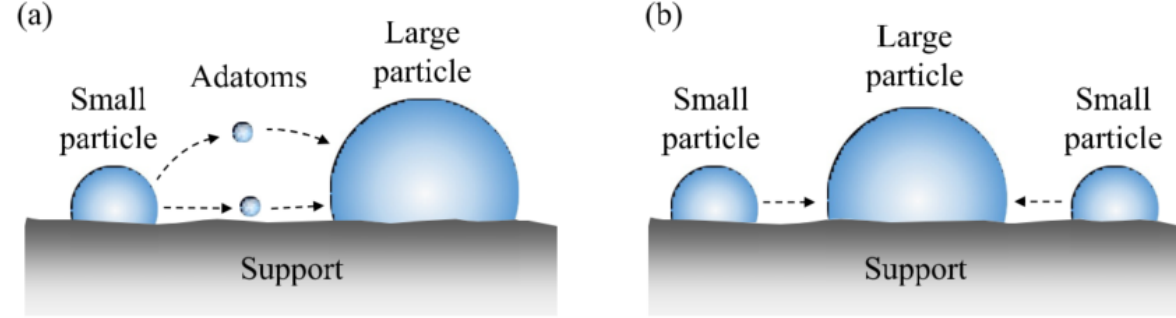
Figure 7. Conceptual models representing main mechanisms of metal particles sintering (via adatoms migration ( a ) or small particles agglomeration ( b )) due to thermal degradation. Ochoa et al. [17].